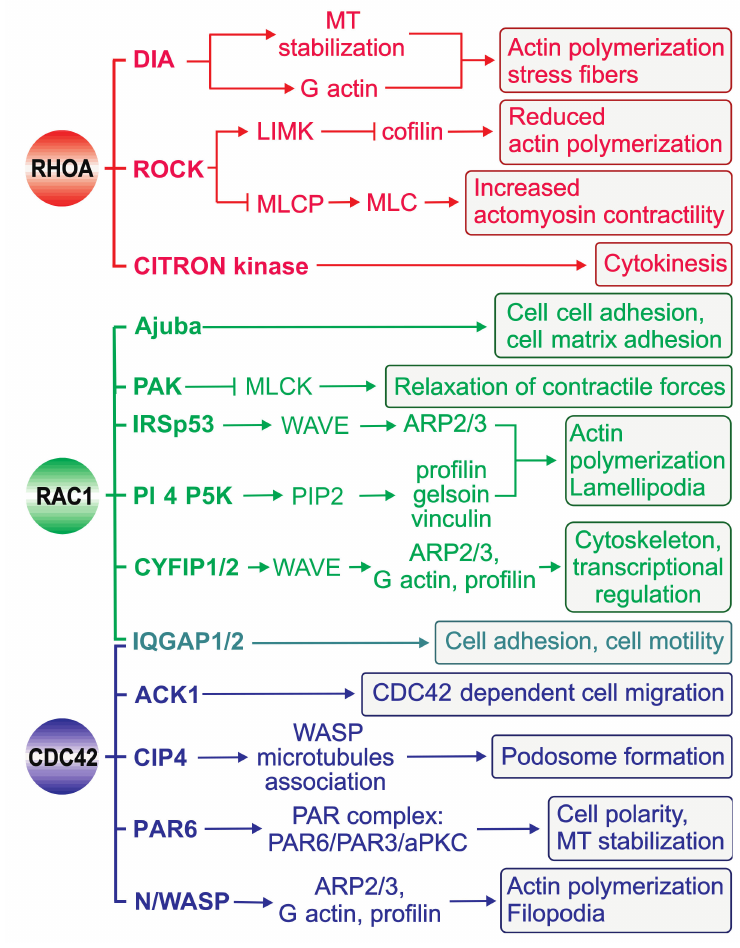
Figure 5. Regulation of actin-based motility by RHOA, RAC1, and CDC42. Activated CDC42, RAC, and RHO bind to and specifically activate their downstream effectors, which are either kinases (e.g., ROCK, PAK, and PI5K) or scaffolding proteins (e.g., DIA, WASP, IRSp53, and IQGAP). These effector proteins activate diverse signaling pathways with distinct effects on the actin cytoskeleton and cellular morphology. An important aspect of cell motility is the equilibrium between the myosin light chain (MLC) and phosphorylated MLC, which is tightly